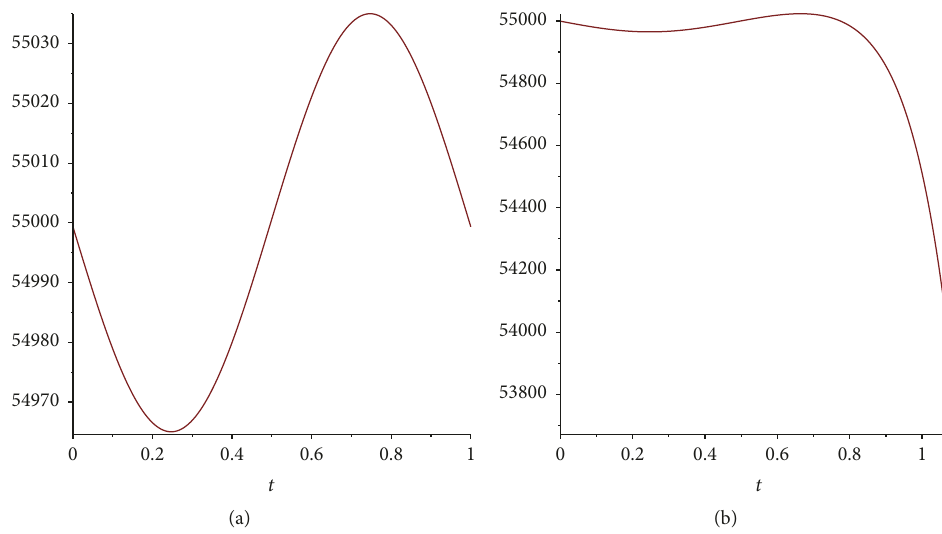
̂𝑆(𝑡) , because it is a periodic function of period 1, is